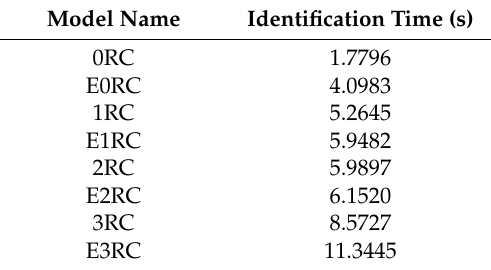
Figure 4. Parameter identification results under NEDC working condition. ( a ) Root-mean-square error (RMSE) comparison for eight models; ( b ) terminal voltage profiles for 2RC and E2RC. Table 4. Identification time of eight battery models (Cell 1@ European Driving Cycle (NEDC)) in the entire state-of-charge (SOC) area.